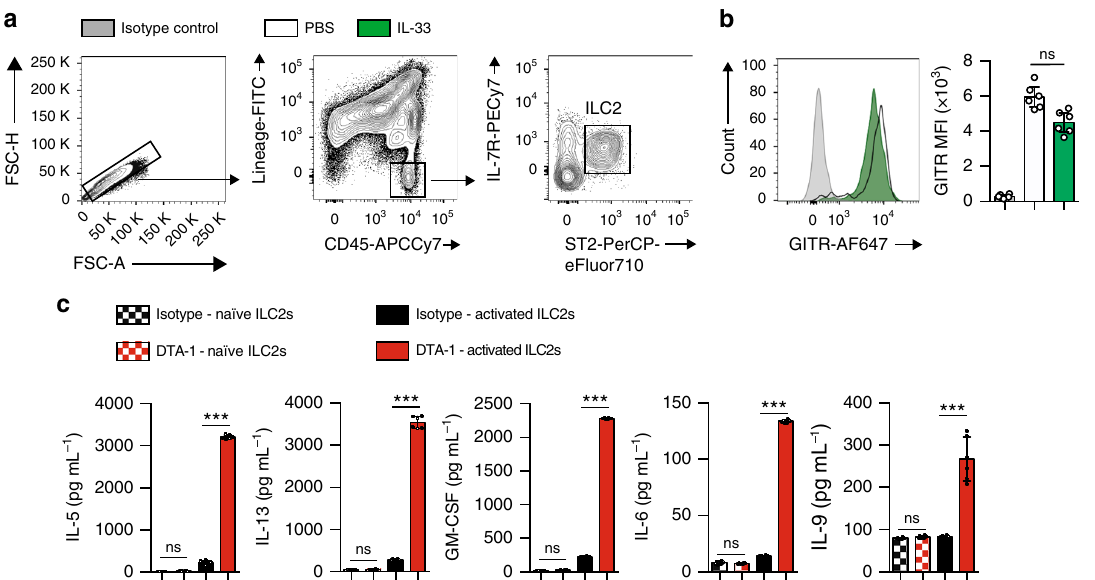
Fig. 1 GITR is expressed on ILC2s and induces Th2 cytokine secretion in activated ILC2s. a Gating strategy of Lin - CD45 + IL-7R + ST2 + ILC2 cells. b Expression of GITR in naïve (white) and IL-33-activated (green) murine white adipose tissue-derived ILC2s compared to the isotype control (gray). Corresponding quantitation of GITR expression shown as MFI + / − SEM, n = 6. c Visceral adipose tissue (VAT) resident ILC2s were isolated from a cohort of naïve C57BL/6 mice and a cohort of activated C57BL/6 mice intraperitoneally challenged with rmIL-33 on 3 consecutive days. Naïve and activated VAT ILC2s were cultured with recombinant mouse (rm) IL-2 and rmIL-7 with DTA-1 (5 µ g/mL) or isotype control for 48 h. The levels of IL-5, IL-13, GM-CSF,